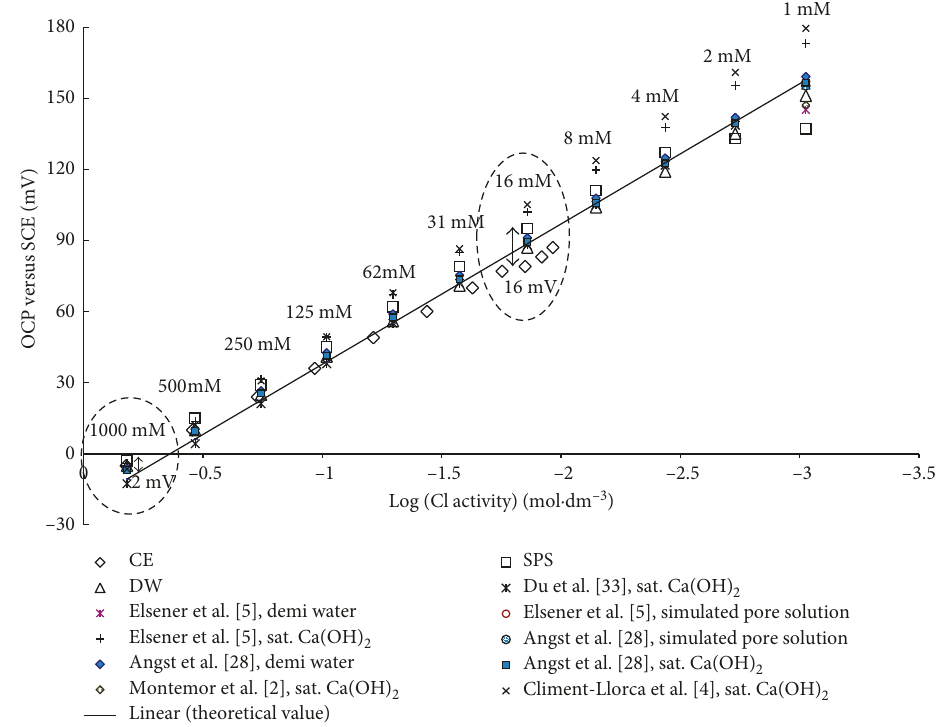
F IGURE 5: OCP response of chloride sensors versus the activity of chloride ions in different